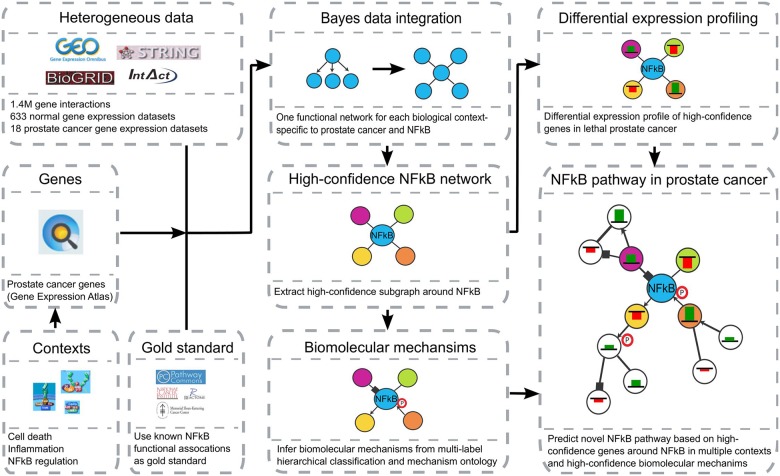
Computational recovery of mechanistic pathway components specific to the NFκB pathway as perturbed in prostate cancer.First, we integrated 18 prostate cancer-specific expression datasets and 633 non-disease datasets from expression (GEO), as well as 1.4M physical interactions (IntAct, BioGrid) and functional associations (Prosite, Domine, STRING), using prior knowledge from PathwayCommons which was refined by 9 biological processes as defined in Gene Ontology and by genes that were up- or downregulated in prostate cancer (Gene Expression Atlas). We trained naïve Bayesian classifiers and inferred context-specific functional networks related to prostate cancer and the NFκB pathway. Additionally, we applied an integrated method for concurrently predicting multiple protein interaction types [24] to assign a biomolecular mechanism to each functionally related gene pair in the final network. Here, we first trained individual Bayesian classifiers for each interaction type, followed by constructing a Bayesian network based on the ontology structure and fixed conditional parameters to constrain the hierarchical semantics of the ontology. Next, we extracted high-confidence subgraphs around NFκB for each context and identified those that are highly functionally related to NFκB in multiple contexts and determined their gene expression levels in an inhouse prostate cancer specific gene expression datasets from the Physicians’ Health Study (PHS) Prostatectomy Confirmation Cohort. Genes that were highly differentially expressed in this dataset (Table 1) were used to extract high-confidence subnetworks for each interaction mechanism, which were then combined as a novel NFκB pathway.